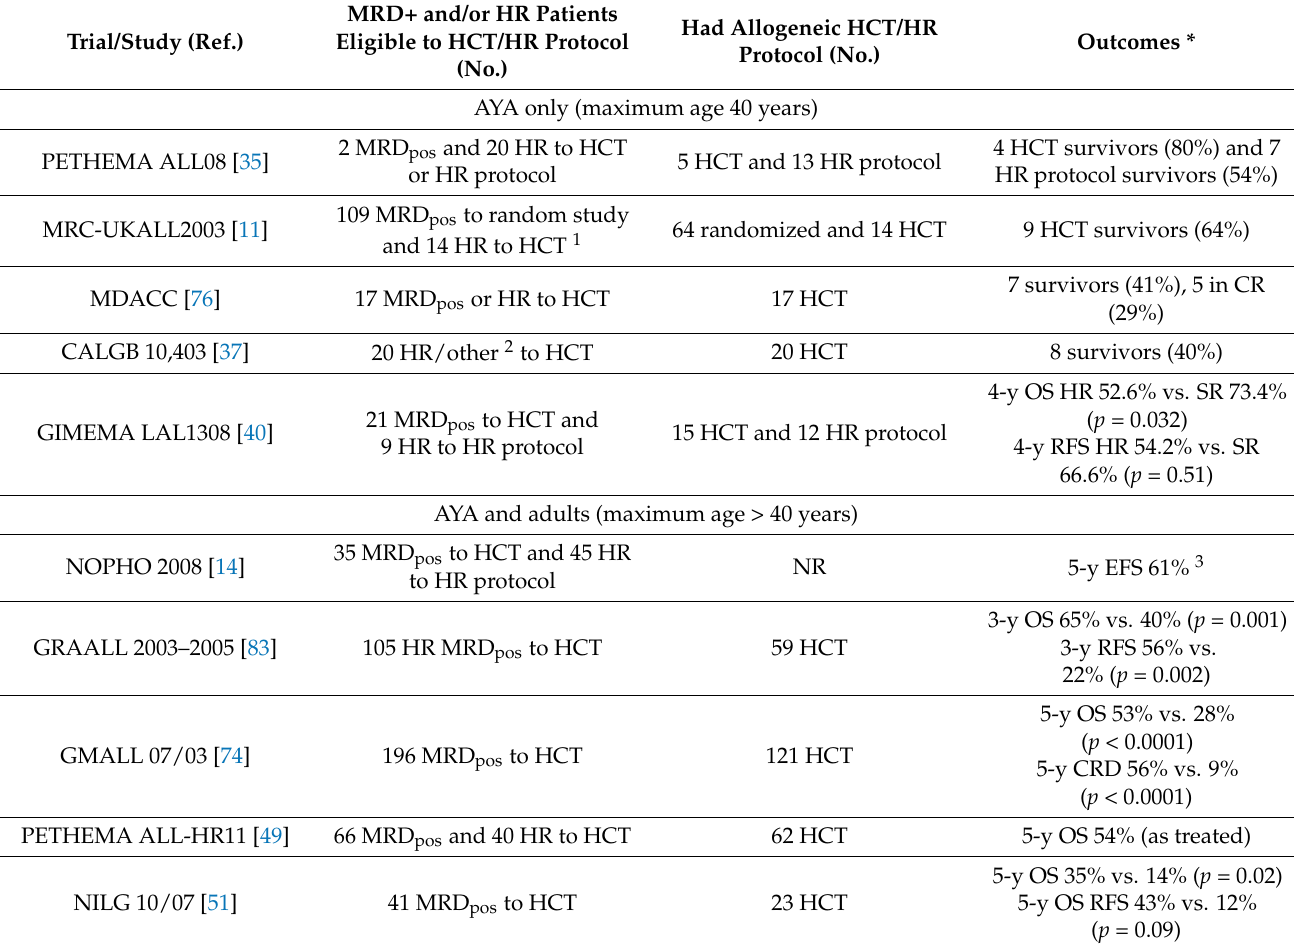
Table 5. Application and results of allogeneic HCT or other intensification protocols for MRD positive and HR states in AYA/adult Ph − ALL.